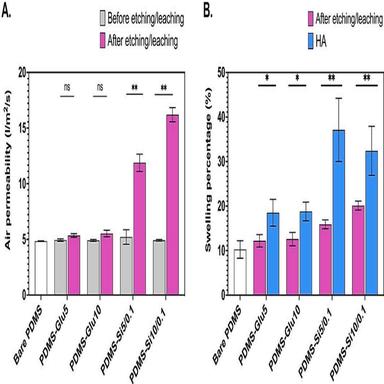
A. Air permeability of bare-PDMS vs PDMS-Glu and PDMS-Si. B. Swelling of bare-PDMS vs PDMS-modified MNs after etching and treatment with HA. Error bars represent SD (n = 3). Symbology: \ indicates significant differences between different treatment conditions in the same sample and ns indicates non-significant differences (n = 3). 0.1234 (ns); 0.0002 (\), <0.0001 (\\).